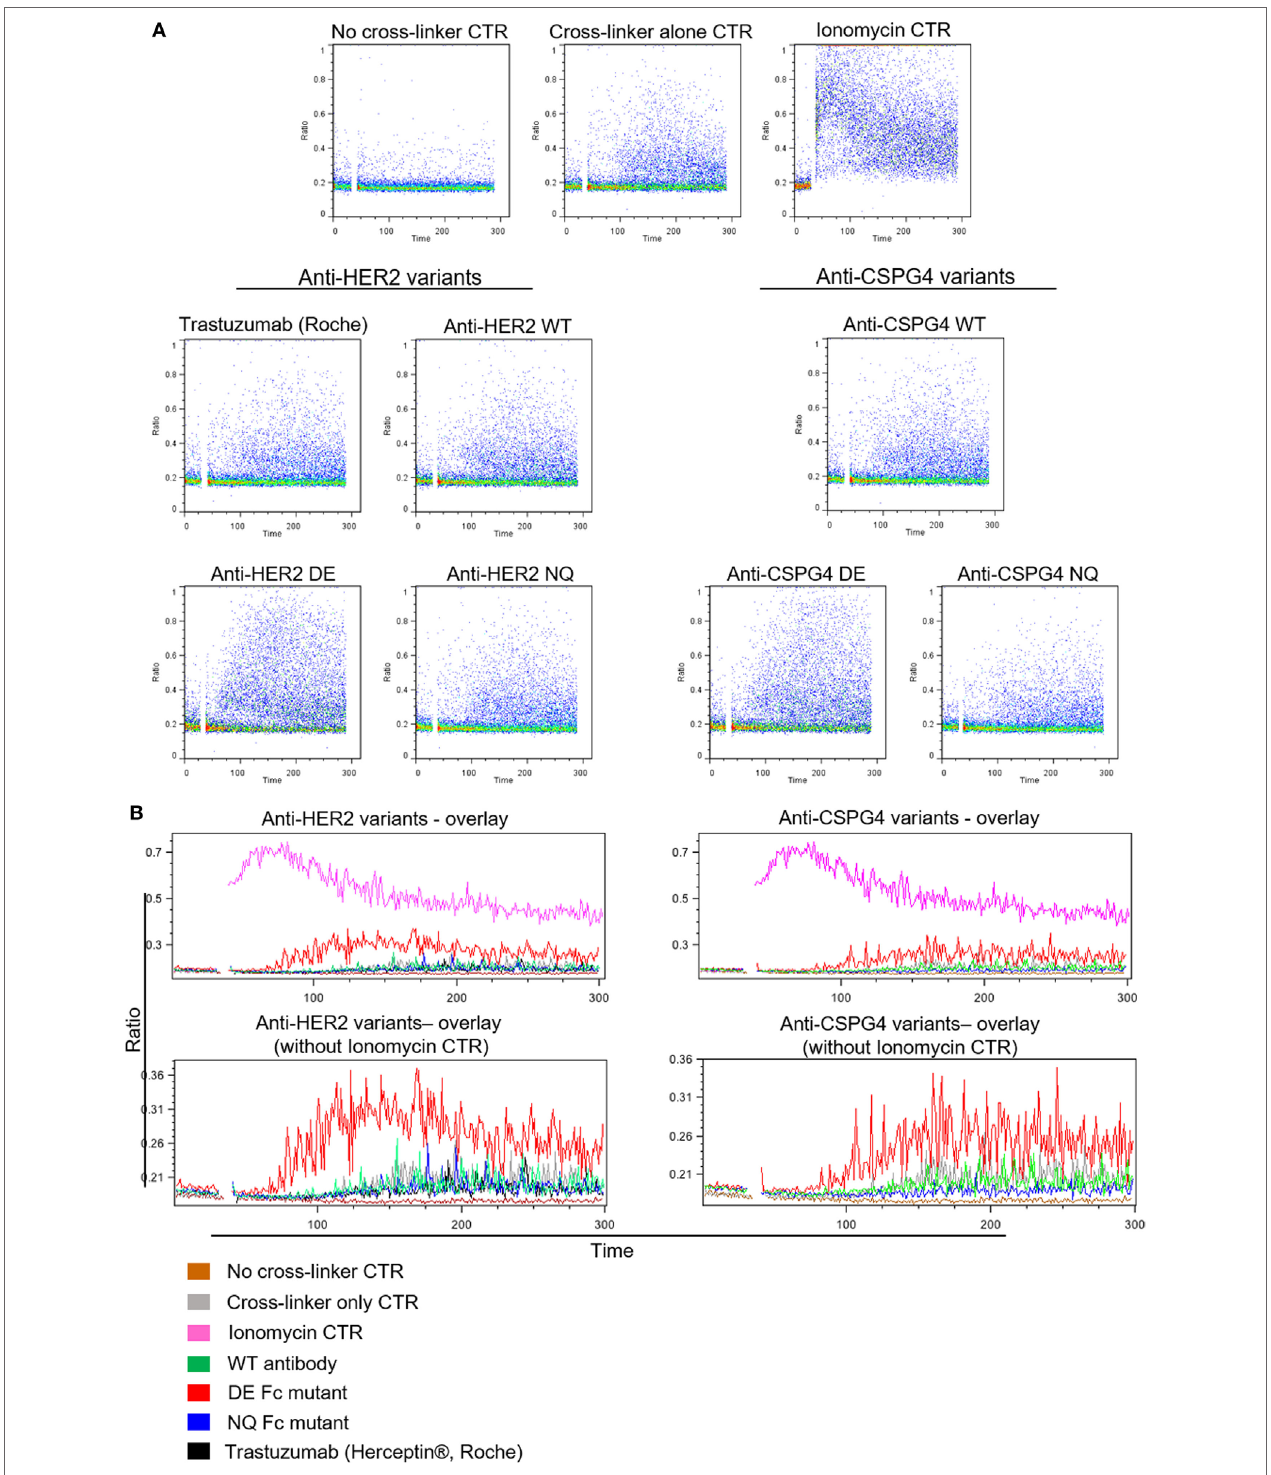
FigUre 6 | Antibody Fc-mediated calcium mobilization of human NK cells. (a) Flow cytometric dot plot graphs of Ca ++ flux assay measurements showing activation of NK cells pre-incubated with different anti-HER2 Fc (left) and anti-chondroitin sulfate proteoglycan 4 (CSPG4) (right) Fc variants after cross-linking with a polyclonal anti-IgG antibody. Ca ++ flux into the cells was visualized through the increase in the DAPI/Indo-1 (blue) ratio over time. (b) Histogram overlay demonstrating the differences in Ca ++ influx between different anti-HER2 (left) and anti-CSPG4 (right) antibody variants depicted as the changes in the DAPI/Indo-1 Blue fluorescence ratio over time. The top overlays include all antibody variants and controls and the bottom exclude the ionomycin control to more clearly demonstrate the differences between the antibody variants on a smaller scale. Data representative of three independent